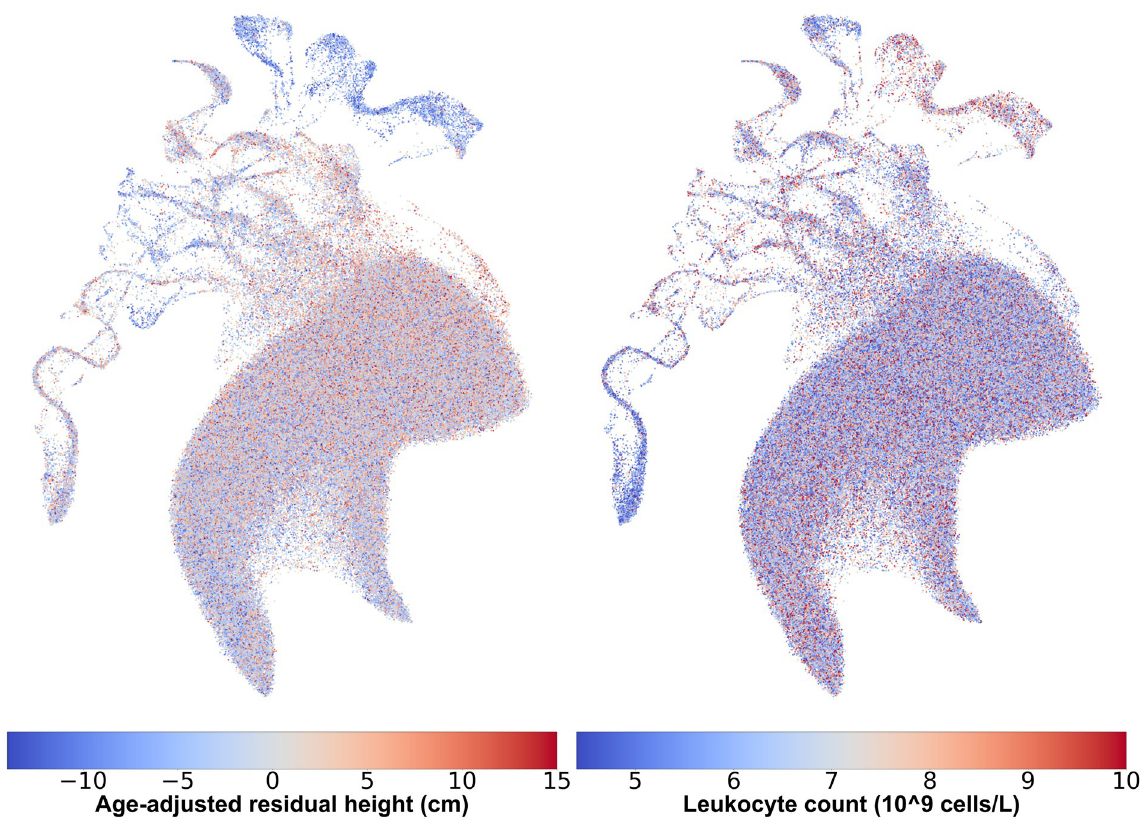
Fig 6. UMAP captures relationships between population structure and phenotype heterogeneity. Females from the UMAP projection in Fig 3B, coloured by age-adjusted difference from mean population height (left) and leukocyte counts (right). Individuals with missing data were excluded. To protect participant privacy, data in these images has been randomized as explained in the materials and methods